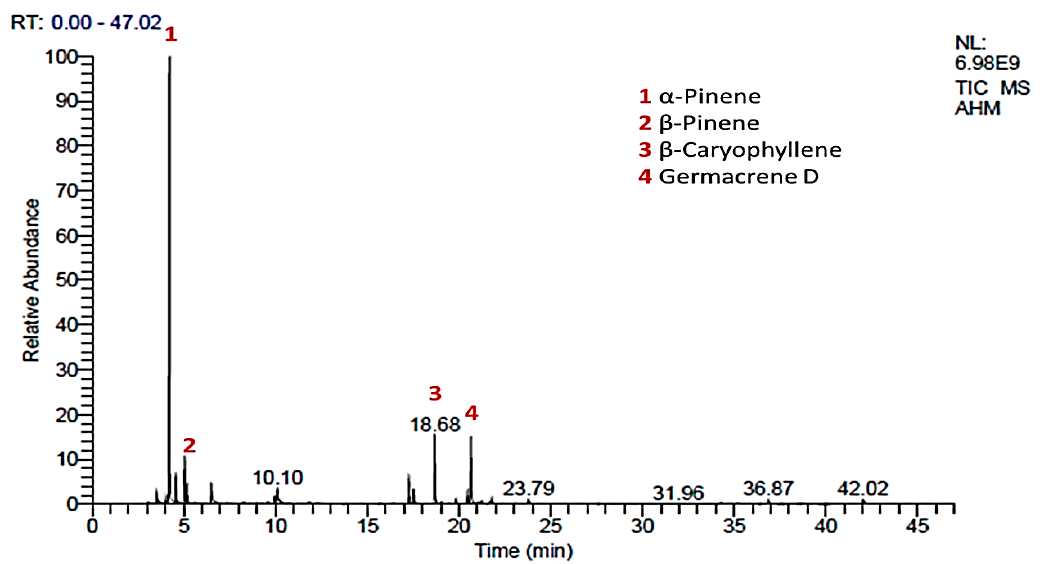
Figure 1. GC-MS analysis chromatogram of MA-EO of Egyptian Araucaria heterophylla resin. Table 1. Chemical compounds of microwave-extracted essential oil (MA-EO) from Araucaria hetero- phylla resin.